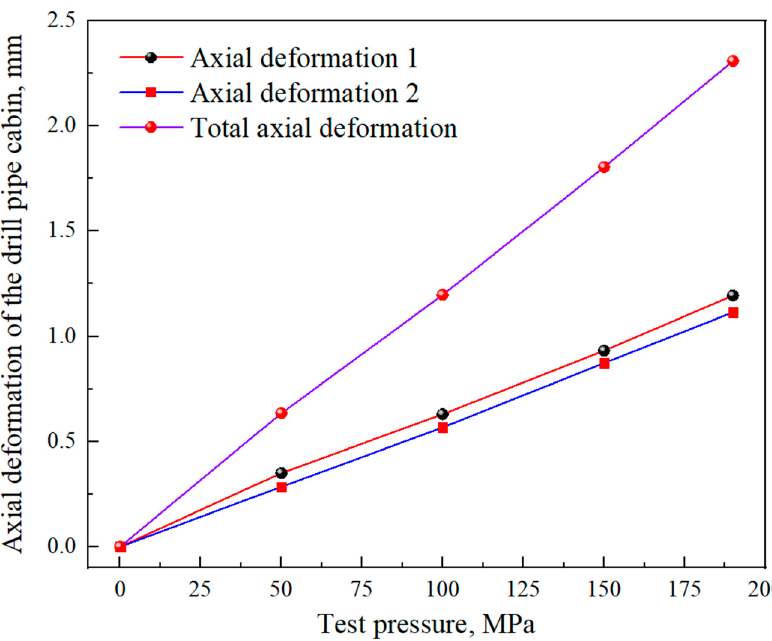
Figure 13. Axial deformation of the drill pipe cabin.